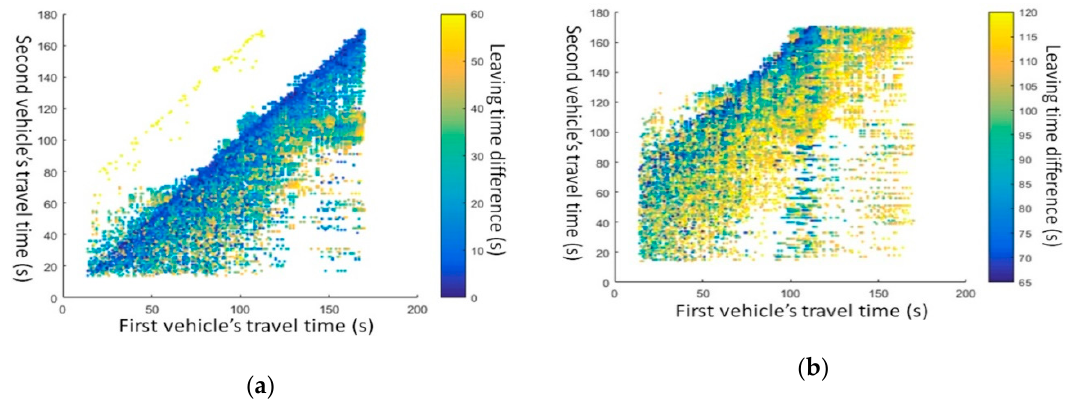
Figure 4. Relationship between the travel times of two object vehicles: ( a ) LTD within 60 s; ( b ) LTD more than 60 s.